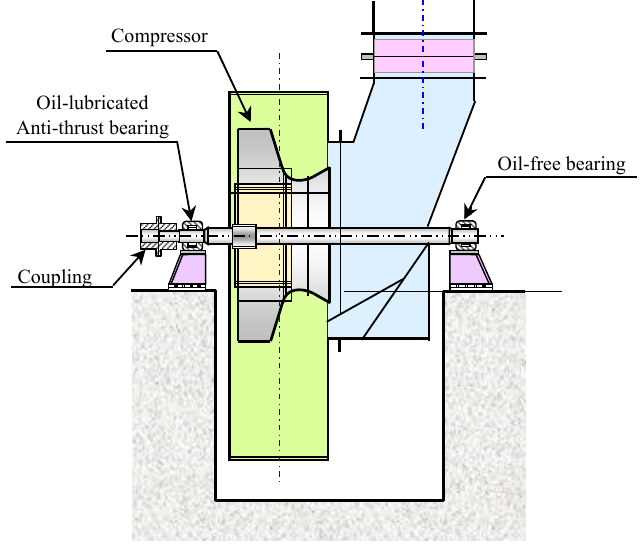
Figure 27. Schematic diagram of the booster fan in the blast furnace gas power plant.